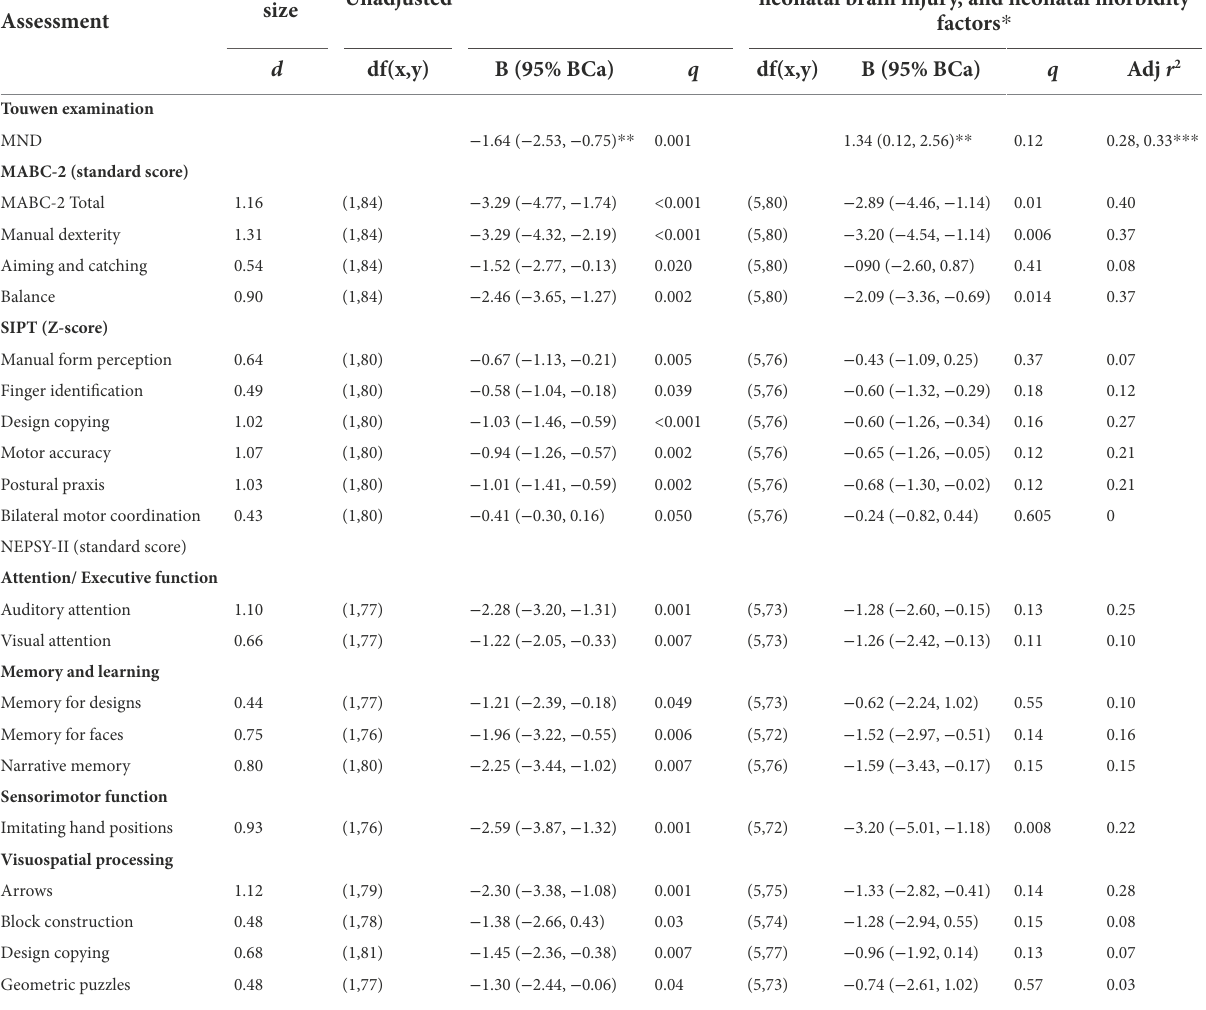
TABLE 3 Group comparisons of extremely preterm and term-born children in assessments with wild bootstrapped multiple